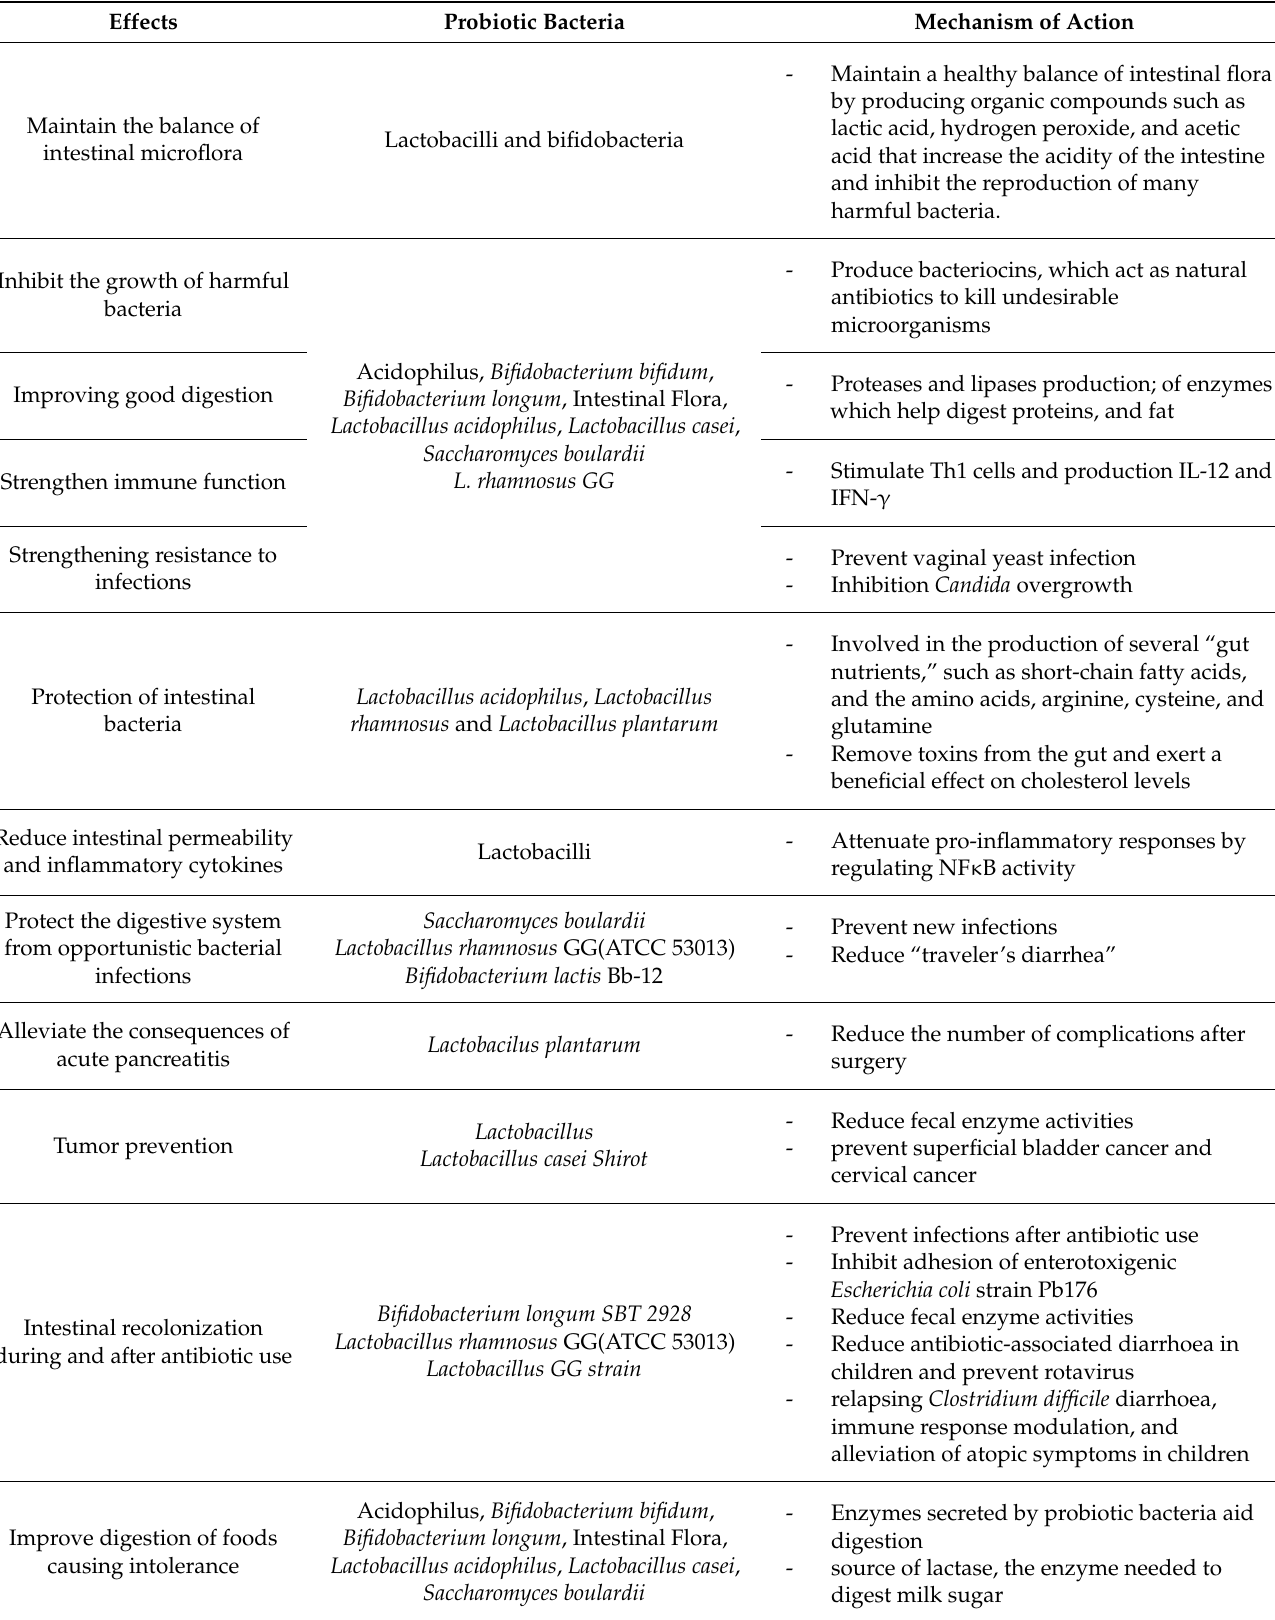
Table 3. Main effects of